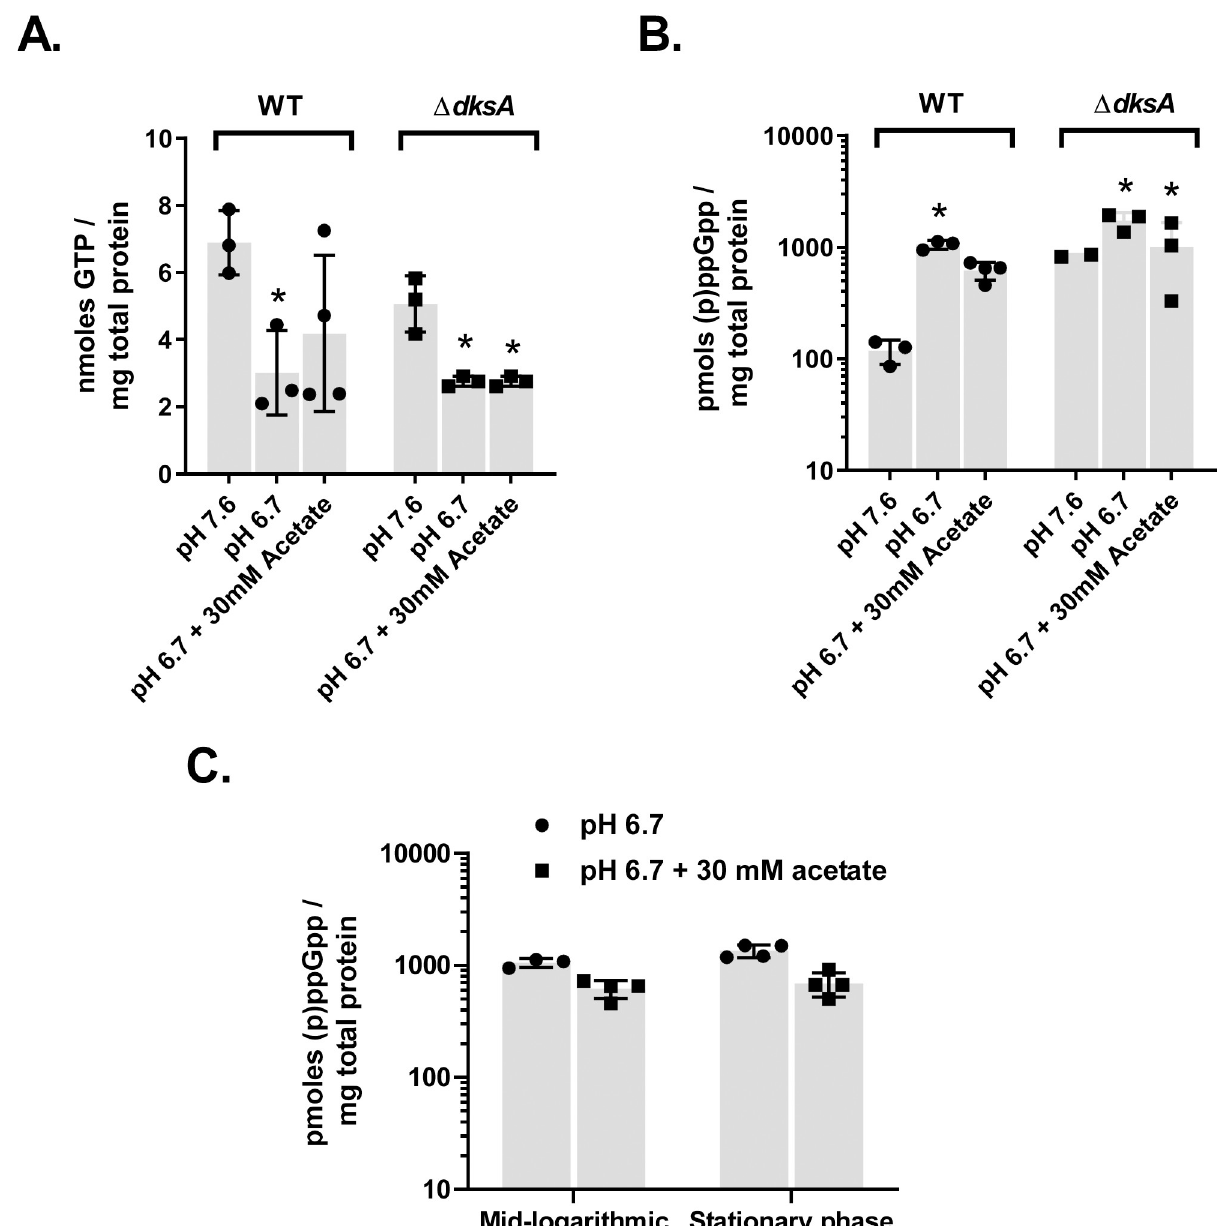
Fig 9. GTP and (p)ppGpp content of B . burgdorferi cells in response to culture media pH and organic acid content. Wild-type (WT) and Δ dksA strains cultured in BSK II pH 7.6 or in BSK II pH 6.7 with or without 30 mM acetate to 2–4 x 10 7 spirochetes � ml -1 were collected to measure (A) GTP and (B) (p)ppGpp content by HPLC. Three replicate experiments were performed. Asterisks indicate p < 0.05 for comparison between WT in BSKII 7.6 measurements and all other measurements in a one-way ANOVA with multiple comparisons test on levels of GTP and ppGpp. (C) Wild-type B . burgdorferi cultured in BSK II pH 6.7 with or without 30 mM acetate to either mid-logarithmic (2 x 10 7 spirochetes � ml -1 ) or to stationary (2 x 10 8 spirochetes � ml -1 ) phase were collected to measure cell density dependent (p)ppGpp content by HPLC. Relative measurement and identity of (p)ppGpp were verified by